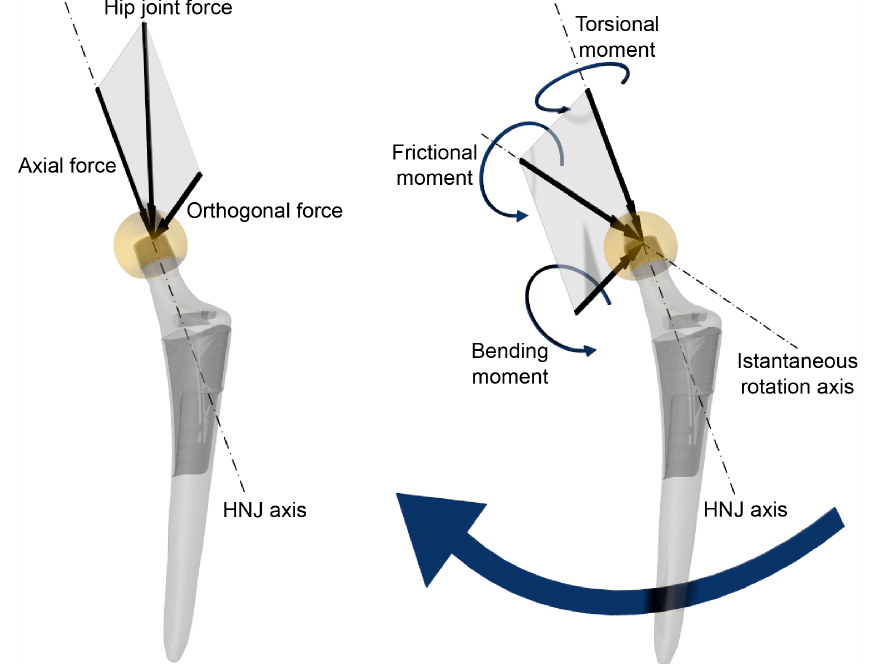
Figure 1. Hip joint load and frictional moment acting on the femoral head. Left: the force acting on the centre of the femoral head is split into two components, an axial force and an orthogonal force to the head-neck junction (HNJ) axis; Right: the frictional moment about the instantaneous rotation axis is split into two components, a torsional moment and a bending moment.